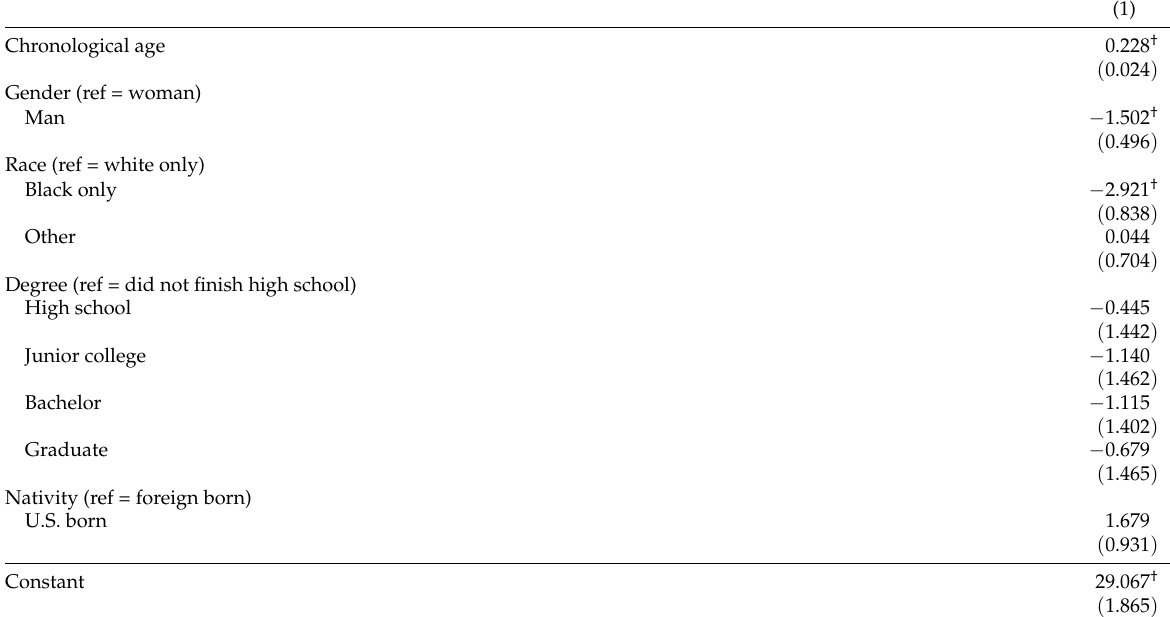
Table 3: Ordinary least squares regression predicting the age perception of a name by respondent characteris- tics (name × respondent